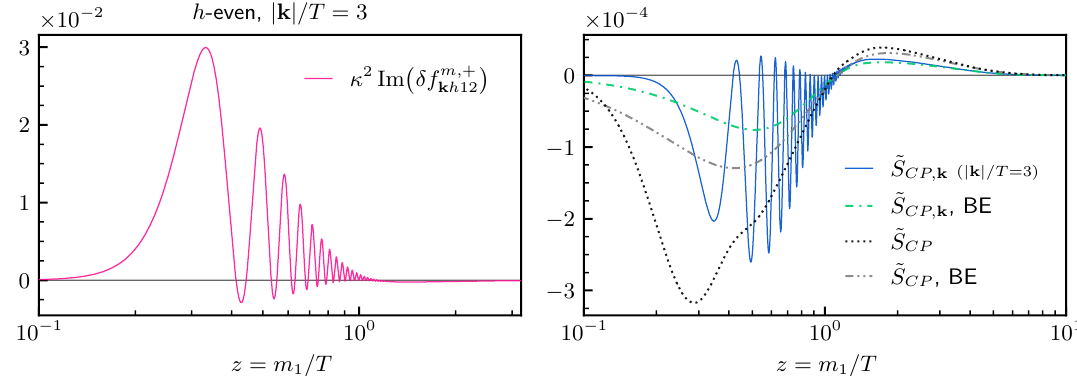
Figure 10. Flavour oscillation of Im( δf m, + )( z ) (helicity-even component) and ˜ S CP , k ( z ) for a k ,h 12 single k -mode, with ∆ m 21 = 0 . 01 m 1 . Other parameters have the benchmark values, and vacuum initial conditions were used. On the right we show the single k -mode as well as the integrated lepton asymmetry source from the full QKEs and the